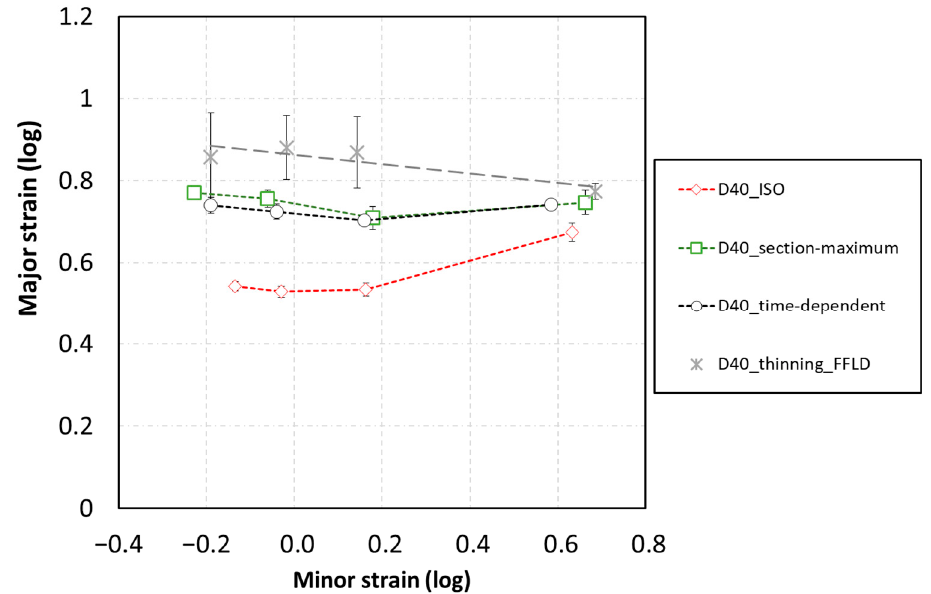
Figure 8. Forming limit diagram of 22MnB5 determined according to ISO standard, time-dependent, section maximum and thinning methods; miniaturized specimens—comparison of the evalua- tion methods.